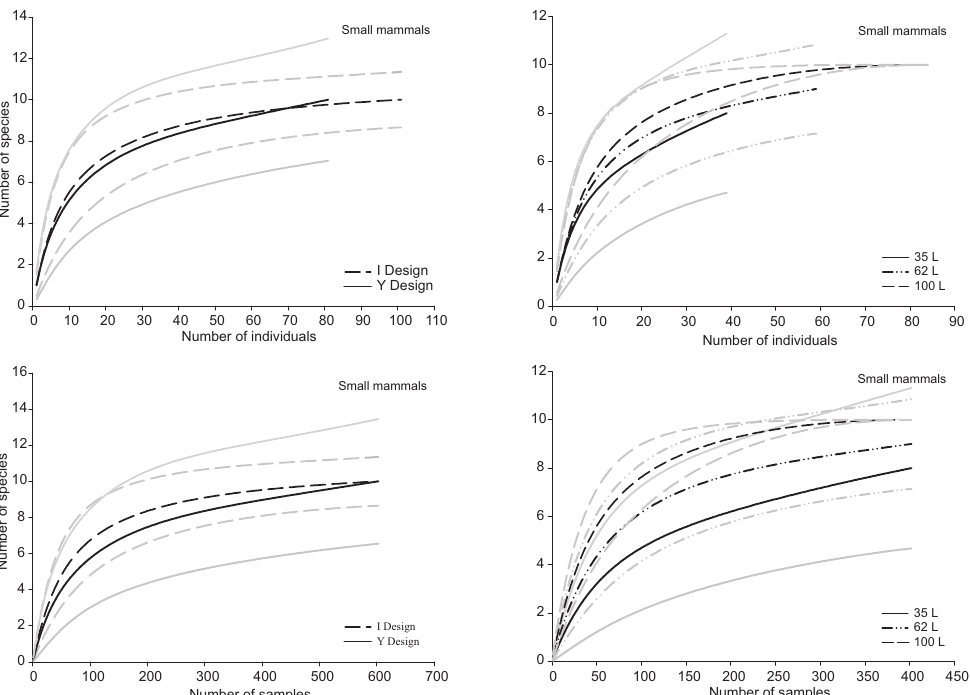
Figure 4. Individual based rarefaction curves and sample based rarefaction curves for small mammals captured by I and Y pitfall trap designs, and 35, 62 and 100 L pitfall traps sizes. Gray lines represent 95% confidence